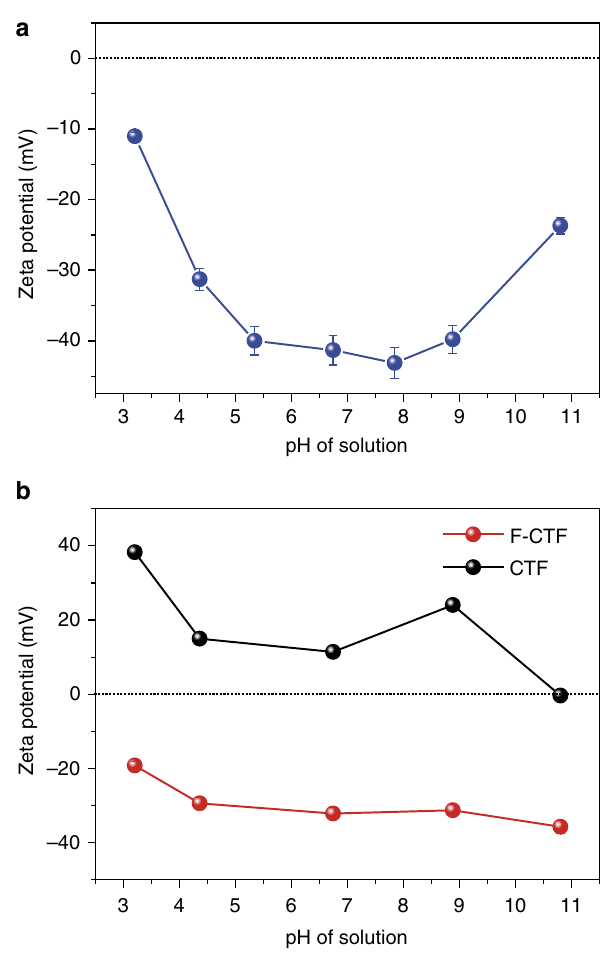
Figure 6 | Zeta potentials. pH-dependent zeta potential of ( a ) COP-99 and ( b ) CTF and F-CTF. Error bars are given to represent